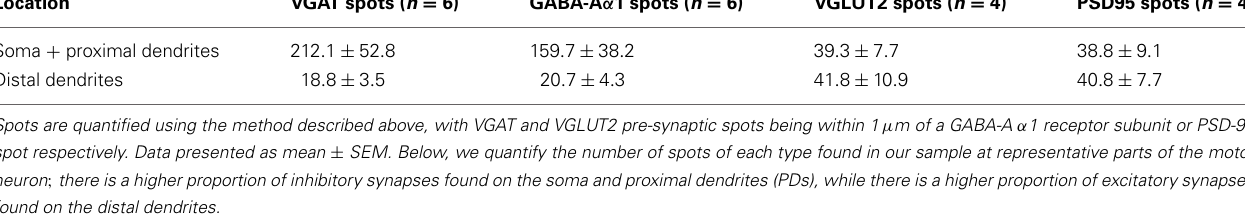
motor neuron cell somas and proximal dendrites. (C) shows distal dendrite of hypoglossal motor neuron double-labeled with inhibitory GABAergic synaptic components VGAT (green) and GABA-A receptor subunit α 1 (purple). (D) shows a distal dendrite of hypoglossal motor neuron double-labeled with excitatory glutamatergic synaptic components VGLUT2 (green) and PSD-95 (purple). Note that the glutamatergic synapses are more prevalent than GABAergic synapses on P0 hypoglossal motor neuron distal dendrites. Scale bar: (A,B) 5 μ m and (C,D) 20 μ m.